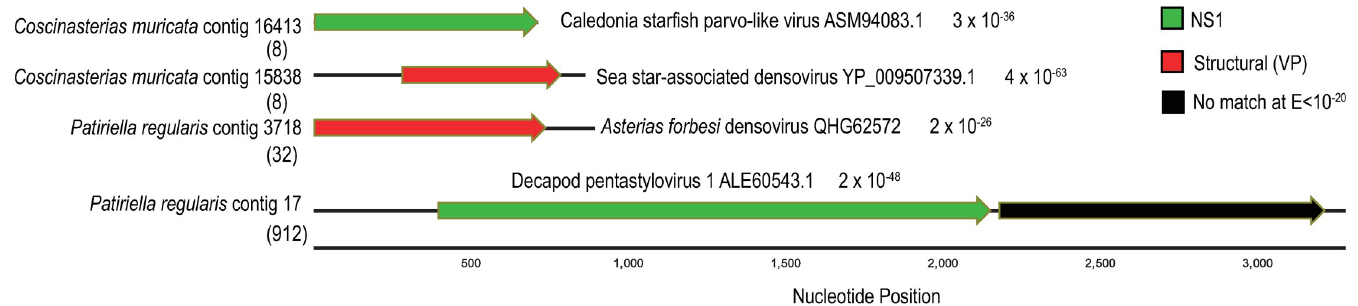
Fig 2. Contig map of densovirus-like genome fragments recovered from Coscinasterias muricata and Patiriella regularis viral metagenomes. The colors of arrows indicate densoviral gene, and the best match (by BLASTx against the non-redundant database at NCBI) along with e-value is indicated adjacent to each ORF. The black lines running through ORFs indicate total contig length. The numbers in brackets below each contig are the number of reads recruiting to the contig from the origin library.